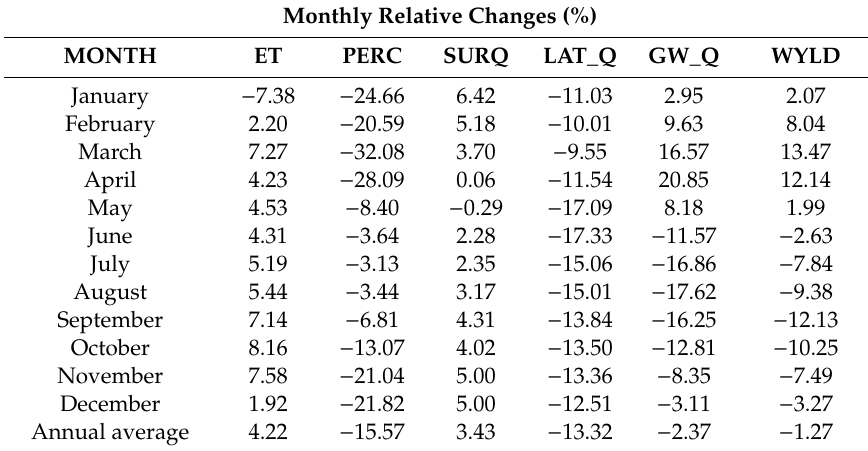
Table 6. Monthly relative change of ET, PERC, SURQ, LAT_Q, GW_Q, and WYLD; scenario LU_1986 vs.